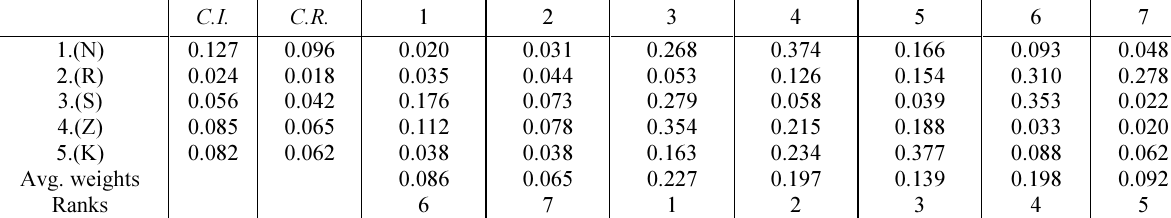
Table 3. The weights of the factors in the main factor groups determined by five experts